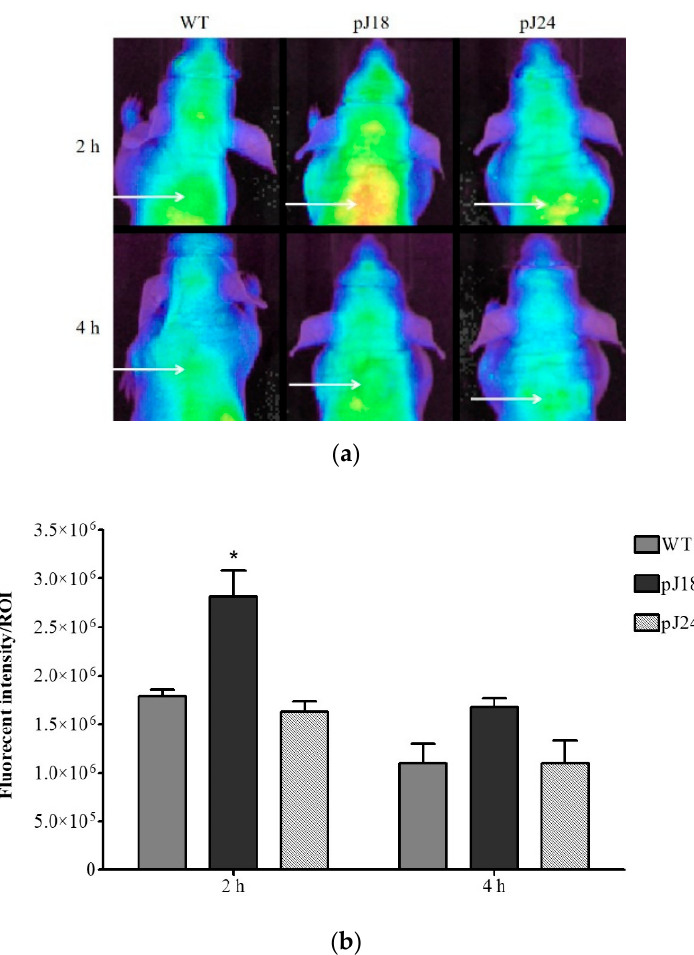
Figure 6. In vivo optical imaging of SKOV-3 xenografted tumors in female nude mice ( n = 2) using AF680-labeled pJ18, pJ24, and WT phage. The mice were injected with 10 12 virions of phage and imaged under anesthesia at 2 h and 4 h post-injection. ( a ) Fluorescence reflectance images of SKOV-3 xenografted mice. A white arrow indicates tumor location. ( b ) Quantification of fluorescent signal intensity of the region of interest (ROI). Fluorescence reflectance images were obtained using a Xenogen IVIS 200 System, and the fluorescent signal intensity was quantified using ImageJ software. Fluorescent intensity/ROI was significantly higher for pJ18 after 2 h compared to WT. A p -value of < 0.05 was considered significant. * p < 0.05.